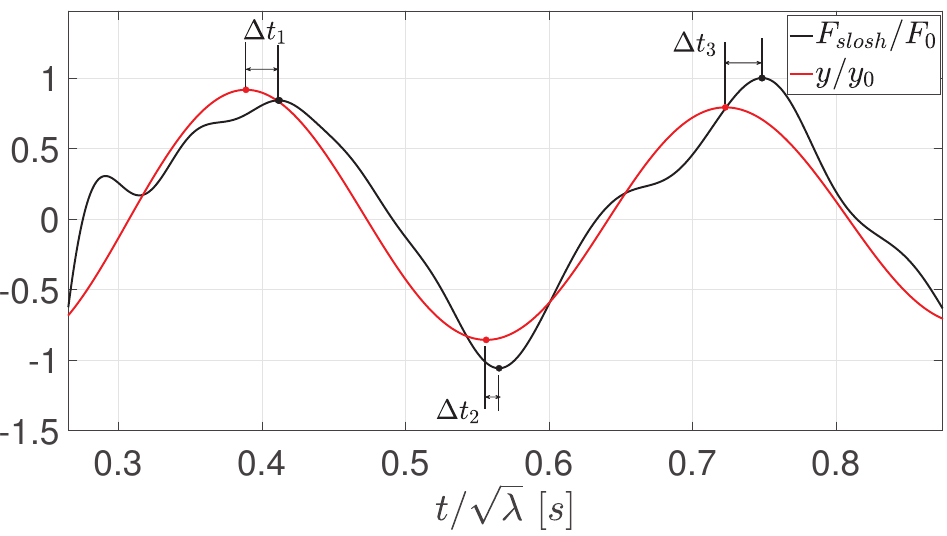
Figure 4. Normalized vertical sloshing force and tank position for a water test at 50% fill level and a 0 = 10 g. The first 3 time-shifts have been indicated as ∆ t 1 , ∆ t 2 and ∆ t 3 . For each time-shift, a phase-shift between the sloshing force is defined and the tank motion as φ i = ∆ t i ω 0 , and the averaged phase-shift for one experiment is the mean over the first 10